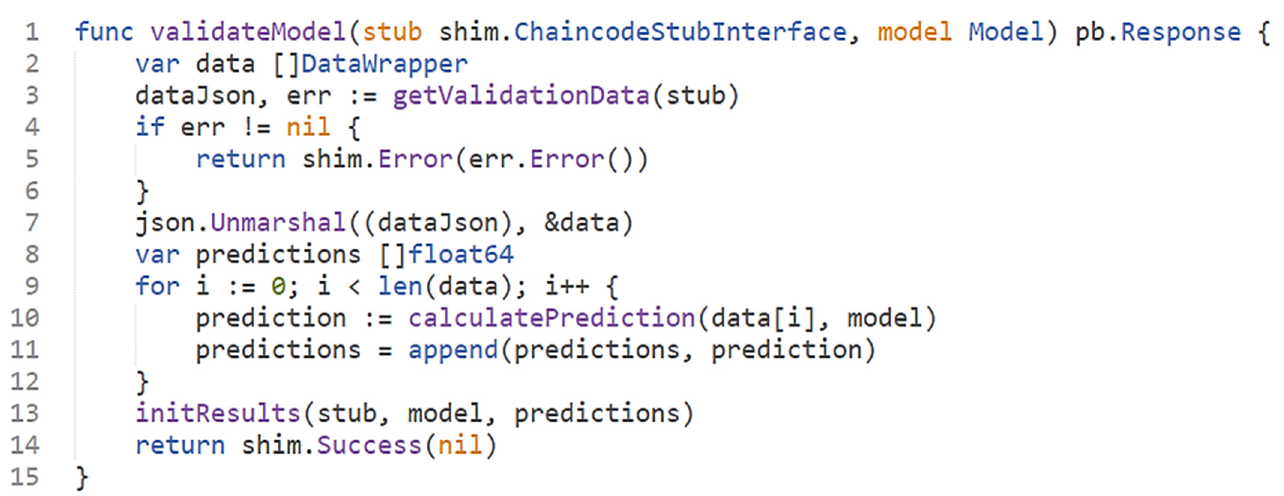
Figure 4. Smart contract behaviour during model validation: UML sequence diagram.